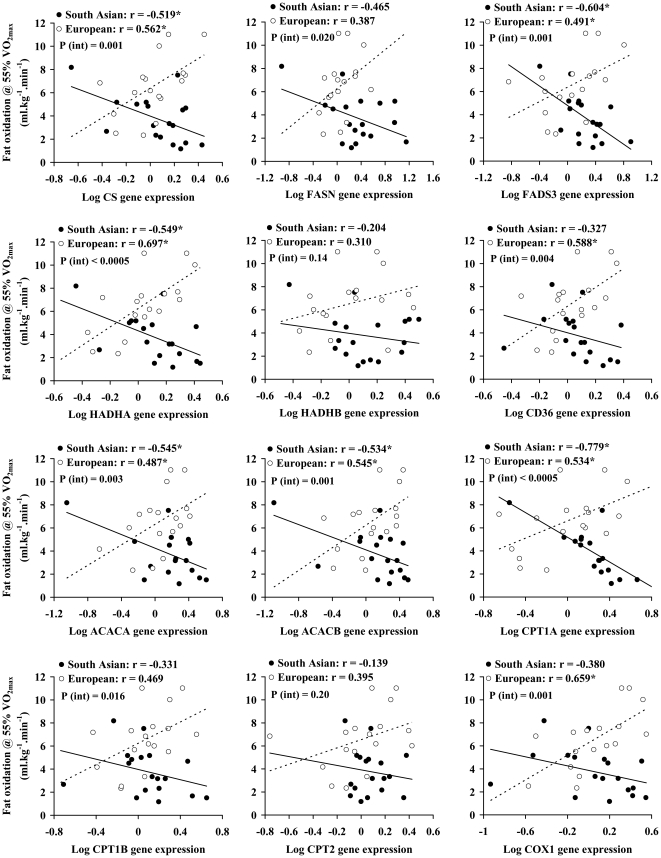
Relationships between exercise fat oxidation and skeletal muscle expression of oxidative and lipid metabolism genes.Significant correlations (p<0.05) are denoted by an asterix. P (int) signifies p-value for interaction in relationship between gene expression and fat oxidation during exercise between European and South Asian groups.